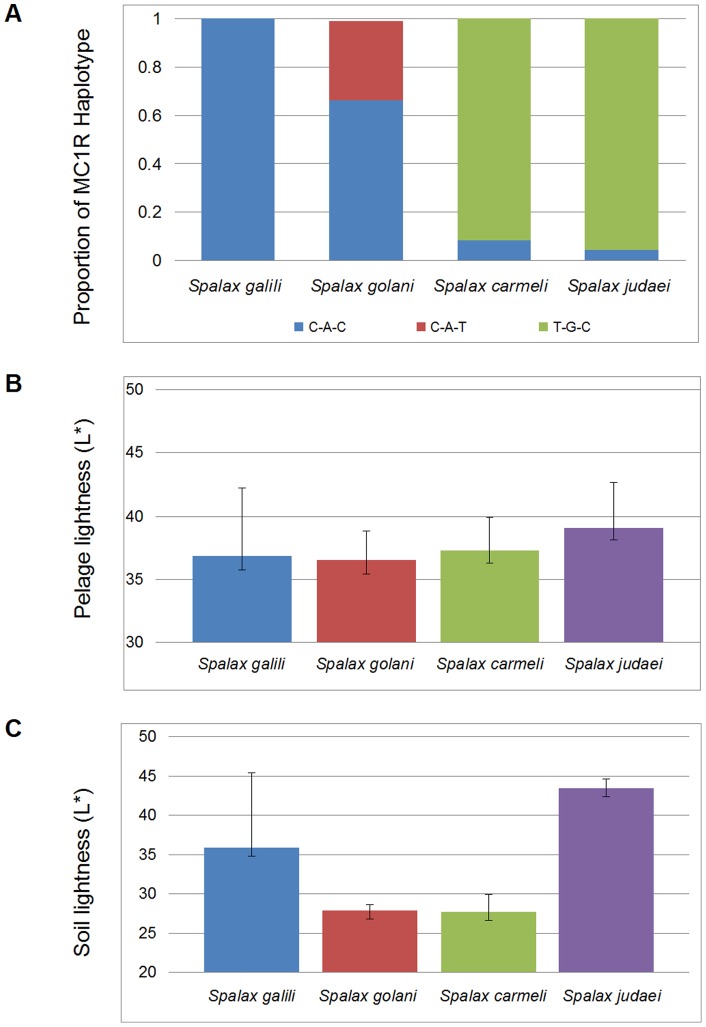
Patterns of variation across species of mole rats in Israel.A) genetic variation, B) phenotypic variation, and C) environmental variation.